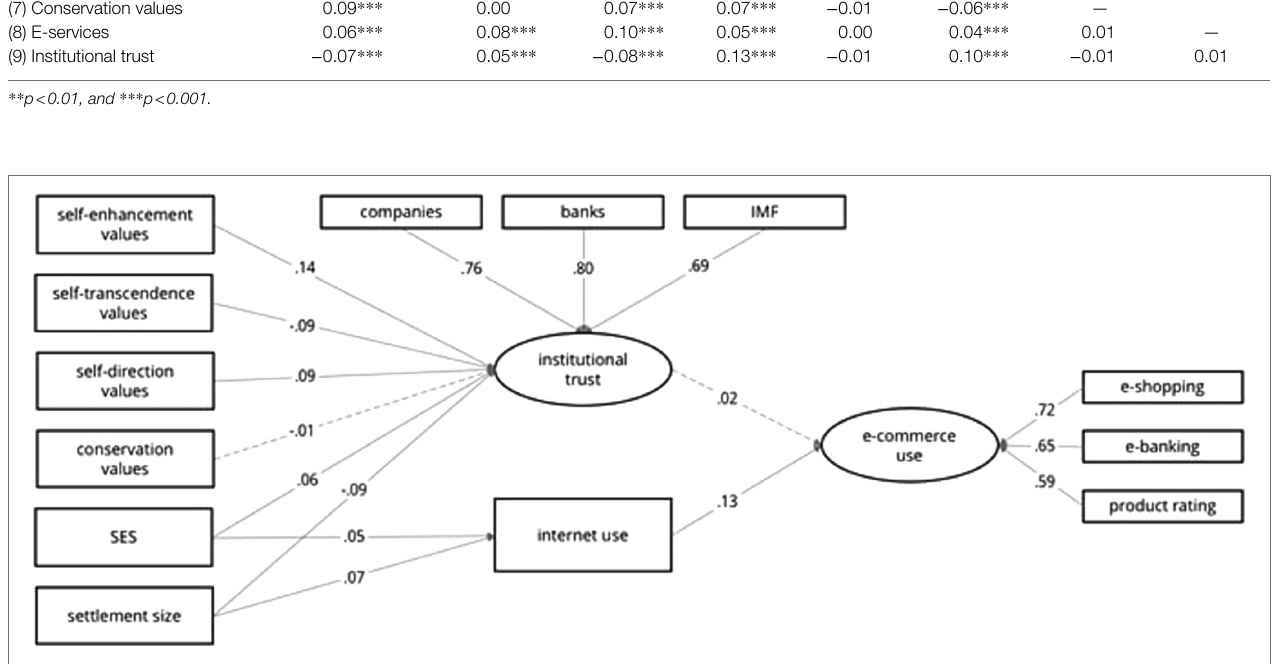
FIGURE 2 | Structural model of the relationship between value orientations, institutional trust and frequency of internet use towards engagement in e-services on the regional level. All solid paths are significant at p < 0.001.